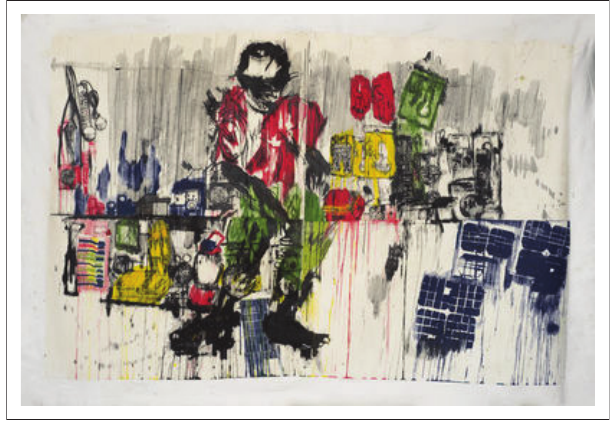
FIGURE 1: Curator’s Black 2015, Masimba Hwati: (a) Coca Cola; (b) Facebook.